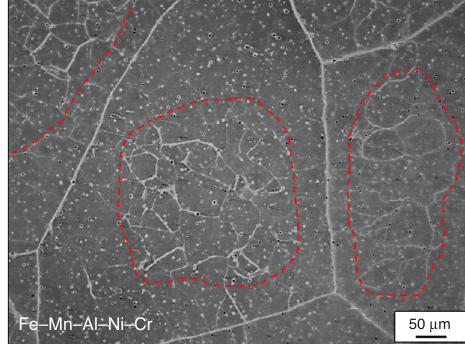
Fig. 7 Characterization of the low density zones in Fe – Mn – Al – Ni – Cr. Optical micrograph of Fe – Mn – Al – Ni – Cr quenched after one single cyclic heat treatment (cf. Supplementary Fig. 1c). Large low-density zones are revealed between the high-angle grain boundaries and the subgrains in the grain interior highlighted by the red dashed